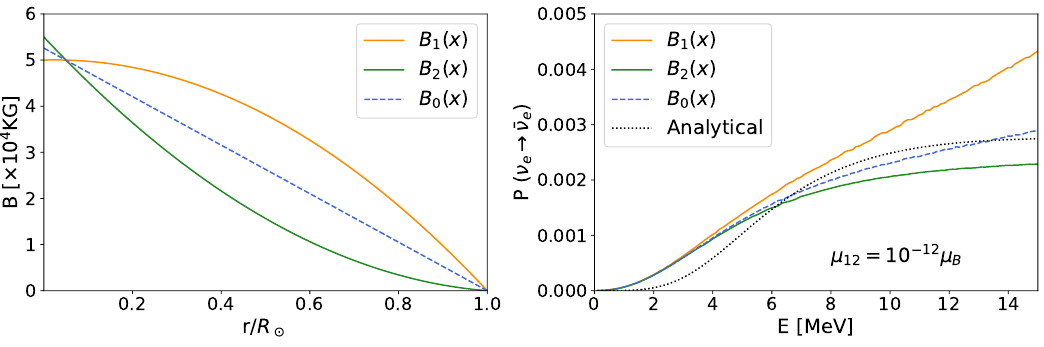
Figure 5 . Left panel: model magnetic field profiles inside the Sun, as defined in eqs. (2.42), (3.4) and (3.5). Right panel: the corresponding electron antineutrino appearance probabilities on the Earth. Results of the analytical expression shown by black dotted curve; for the rest of the curves evolution equations were solved